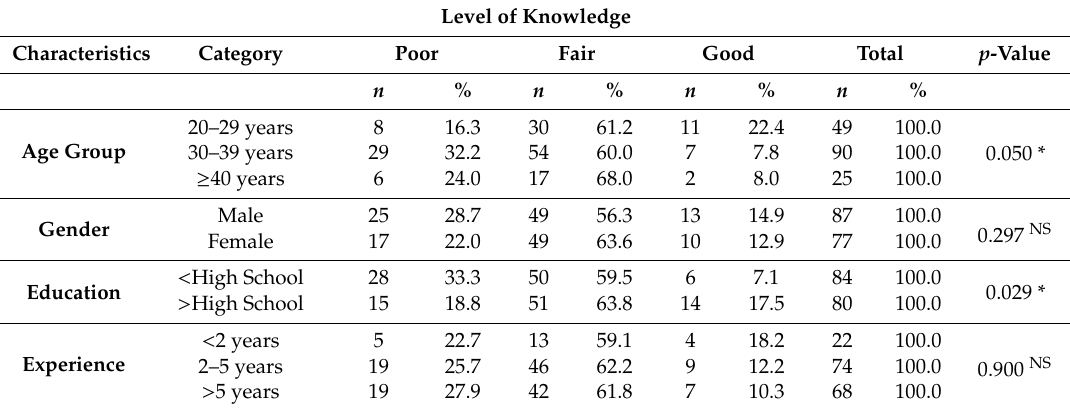
Table 2. Distribution of the level of knowledge according to various demographic characteristics of respondents. Characteristics